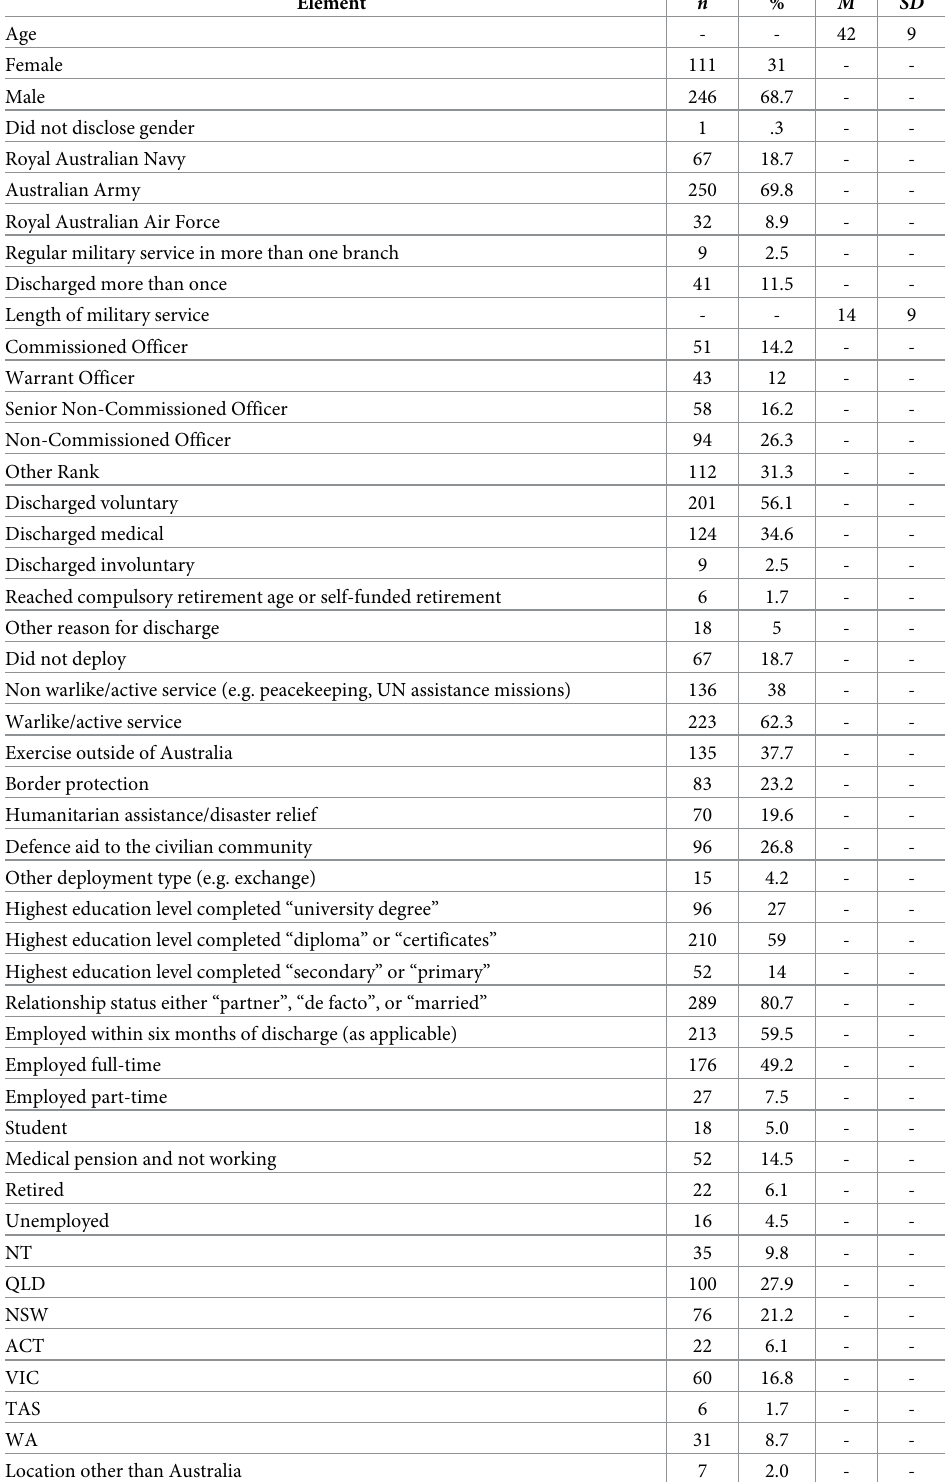
Table 1. Sample profile ( N =